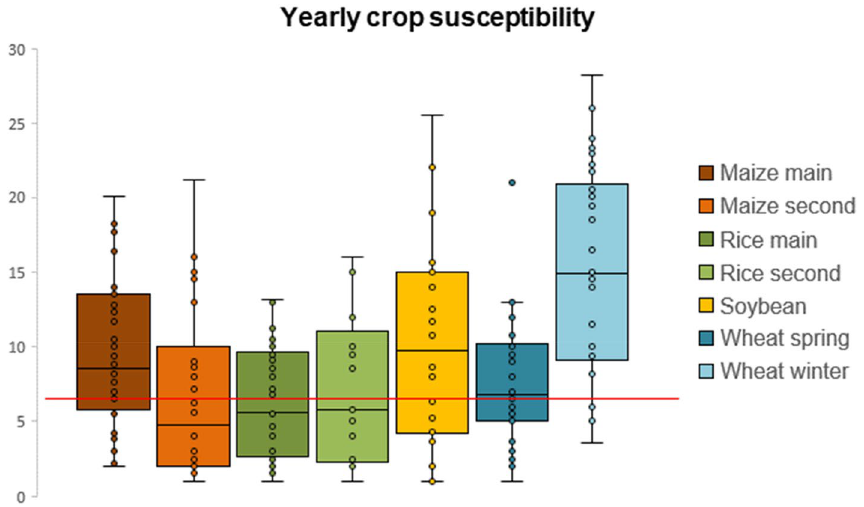
Figure 3. Yearly crop susceptibility to drought-low yield association. Average global occurrence, for each year and cropping system, of SPEI duration-timing combinations with SPEI ≤ − 1 across all the occurrences of SYI ≤ − 1. Single points (some of which overlapping) represent each one year, the box limits indicate the 25th and 75th percentile while the internal horizontal line is the median. The whiskers represent the minimum and maximum after exclusion of outliers (i.e., values outside 1.5 times the interquartile range from the 25th and 75th percentile, respectively). Red line is the 2nd quantile among occurrence values assumed, as in Fig. 2, as the limit between Low and Medium